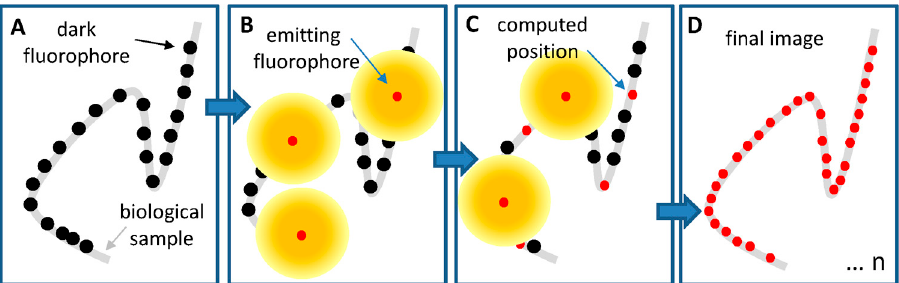
Figure 8. Sequences for stochastic imaging. ( A ) Fluorophores initially in a dark state grafted onto a biological sample; ( B ) Some well-separated fluorophores are activated and their emission (yellow circles) allows for localizing them (red points); ( C ) Deactivation and activation of other fluorophores; ( D ) After n iterations, the final image is created corresponding to the geometry of the biological sample.